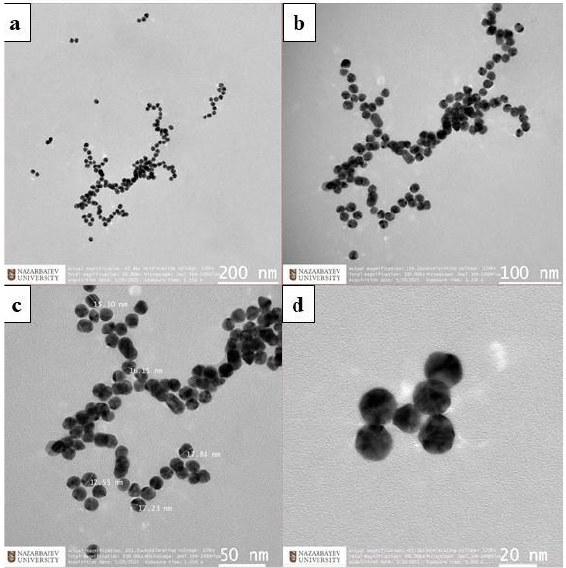
Figure 5. TEM images of AuNPs in different zooms: 200 nm ( a ), 100 nm ( b ), 50 nm ( c ), and 20 nm ( d ). The shape and size of AuNPs equivalent to 15–20 nm spheres in different zooms.